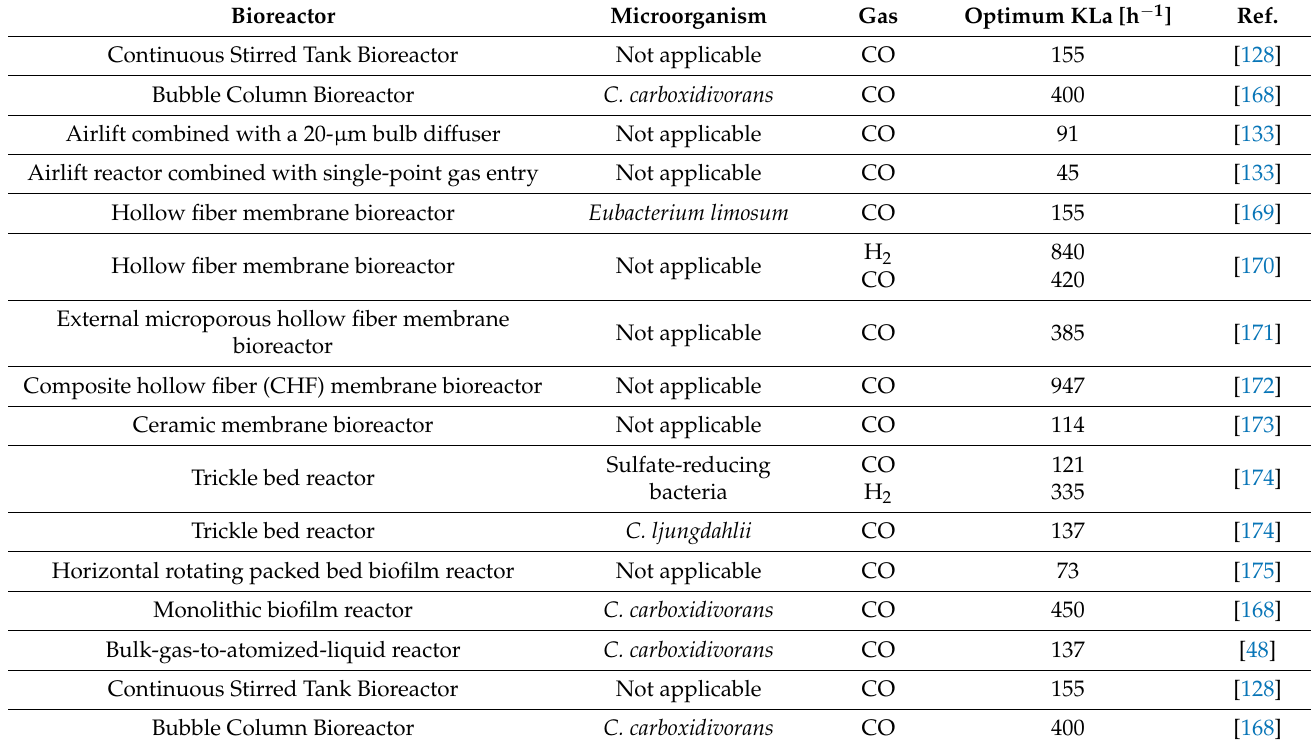
Table 6. Mass transfer coefficient of syngas for various types of bioreactor